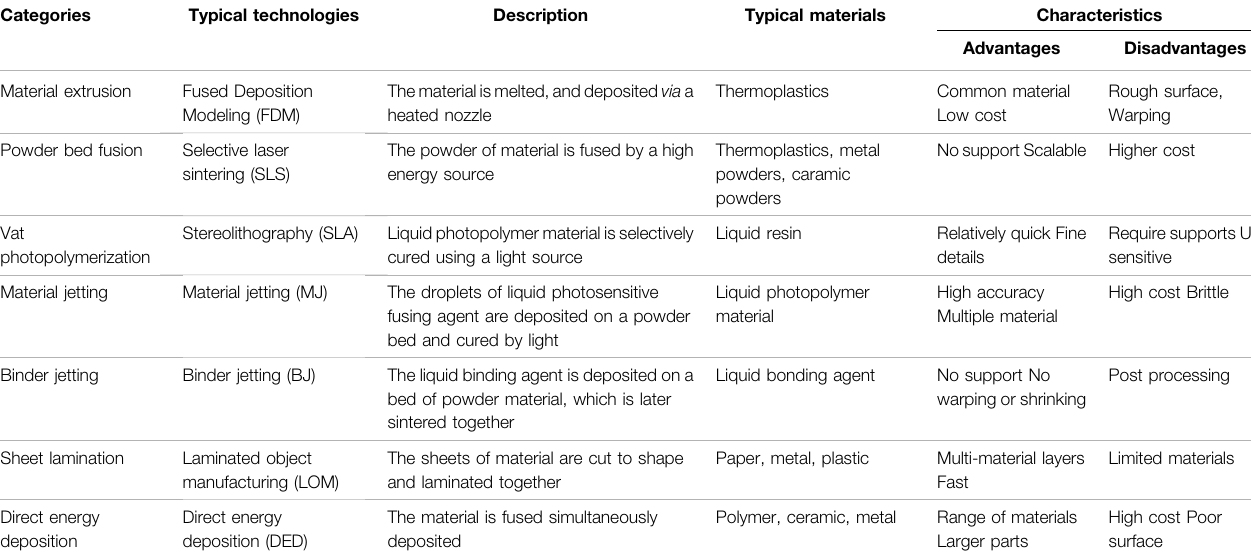
TABLE 1 | Summaries of seven types of 3D printing technologies (Hubs, 2018; Additive Manufacturing Research Group, 2019; Carew and Erlrrickson, 2020). Categories